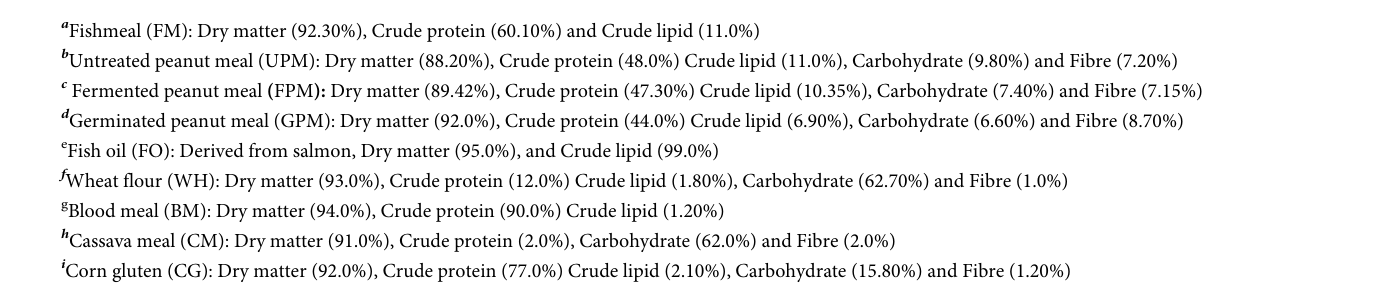
Soy lecithin Mycotoxin binder Vitamin Premix F2 Mold